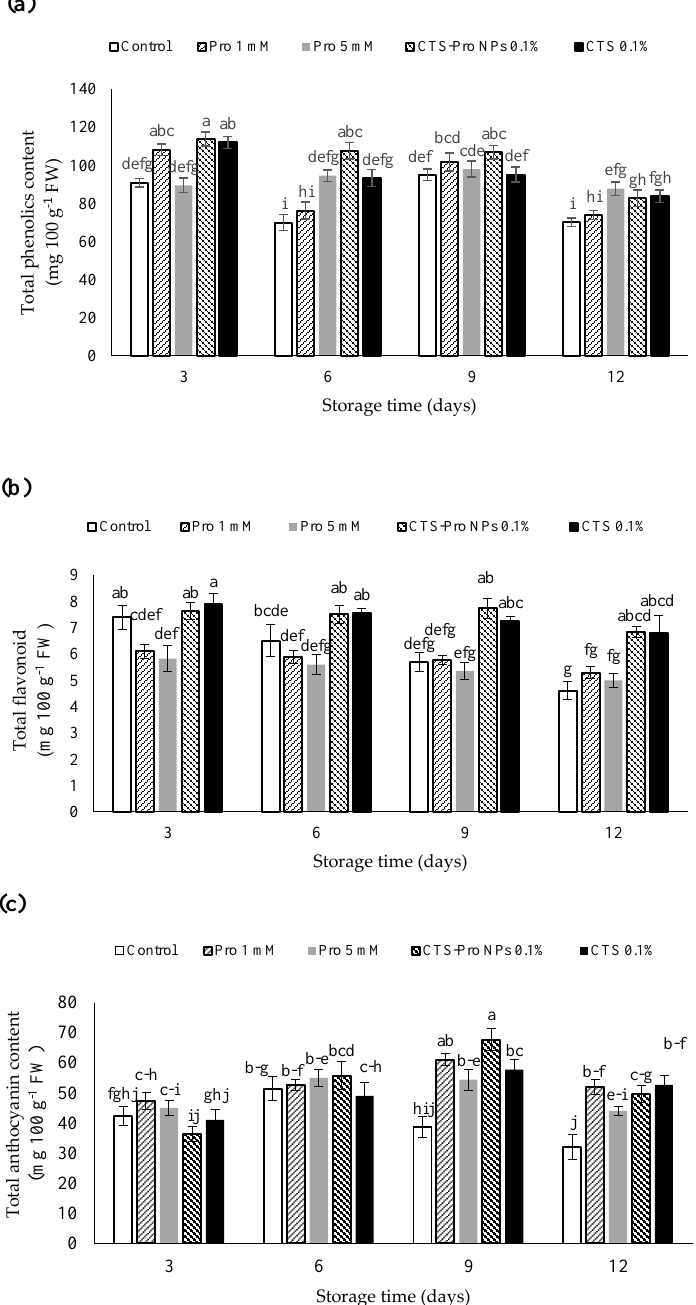
Figure 3. Effect of post–harvest treatments of strawberries with Pro, CTS and CTS–P NPs on ( a ) total phenolics, ( b ) total flavonoids, and ( c ) total anthocyanins during 12 days of storage at 4 °C. Data presented are mean ± SE of three replications. Different letters (a – j) over bars indicate they are significantly different ( p < 0.05) by Duncan’s test.